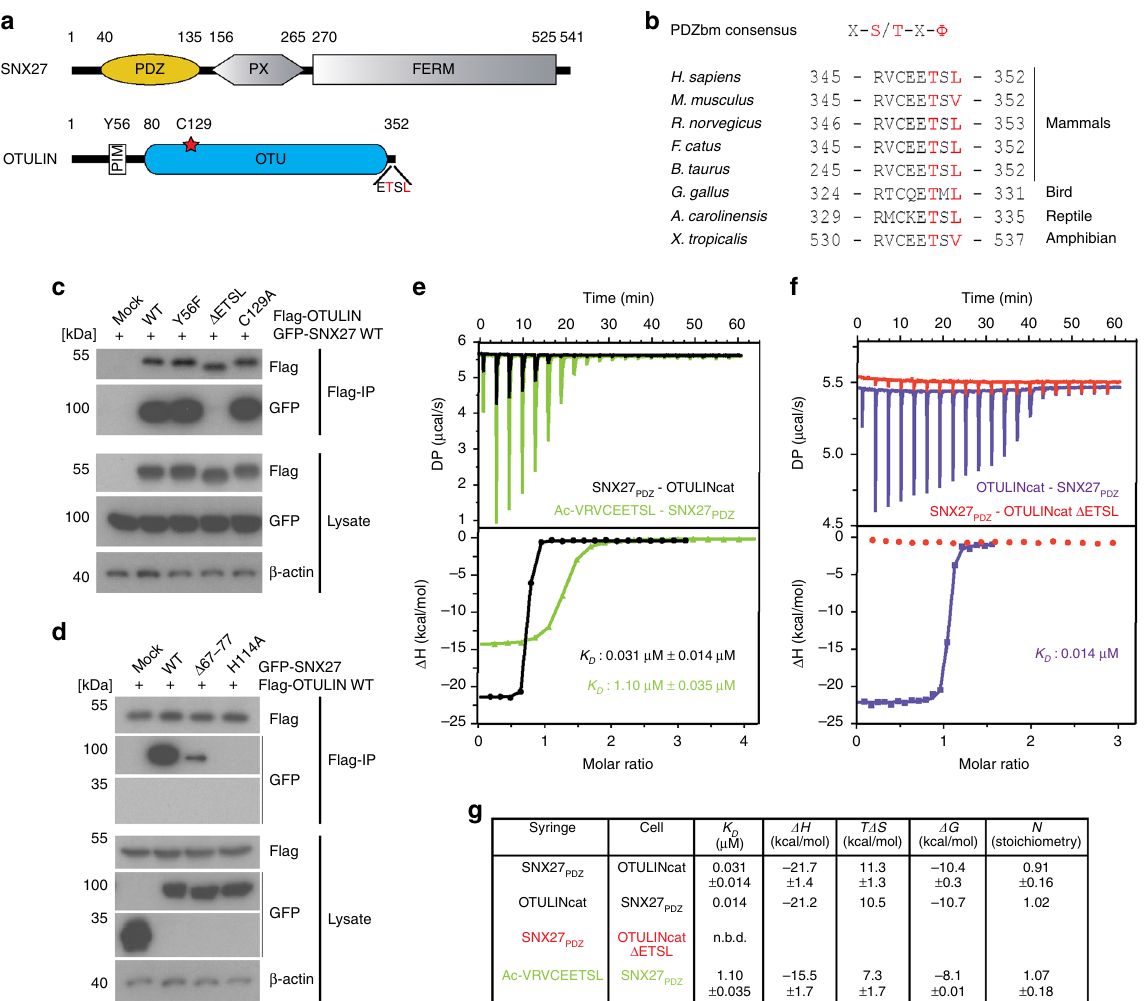
Fig. 2 High af fi nity binding between OTULIN and SNX27. a Schematic representation of human OTULIN and SNX27 domain structure. b Sequence alignment and conservation of C-terminal PDZbm in OTULIN orthologues from tetrapod animals. c , d HEK293 cells were co-transfected with Flag-OTULIN and GFP-SNX27 constructs as indicated. Co-IPs were performed using anti-Flag antibody and tested for OTULIN and SNX27 interaction by WB. e ITC data for OTULIN PDZbm peptide (green) or OTULINcat (black) titrated against SNX27 PDZ domain. f ITC data for OTULINcat Δ ETSL (red) and the reciprocal titration of OTULIN into SNX27 (purple). g Table summarizing the ITC data with mean parameters and the standard deviation derived from at least